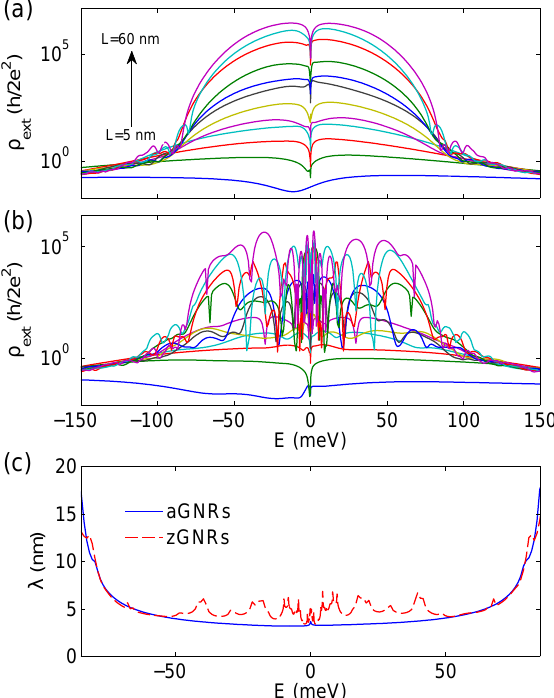
Figure 8. Extrinsic resistivity for ( a ) aGNRs and ( b ) zGNRs with W = 150 nm, L nm and uncompensated vacancies with n = 0 . 1% ; ( c ) Rate of the exponential decay of the extrinsic resistivity in the region of the